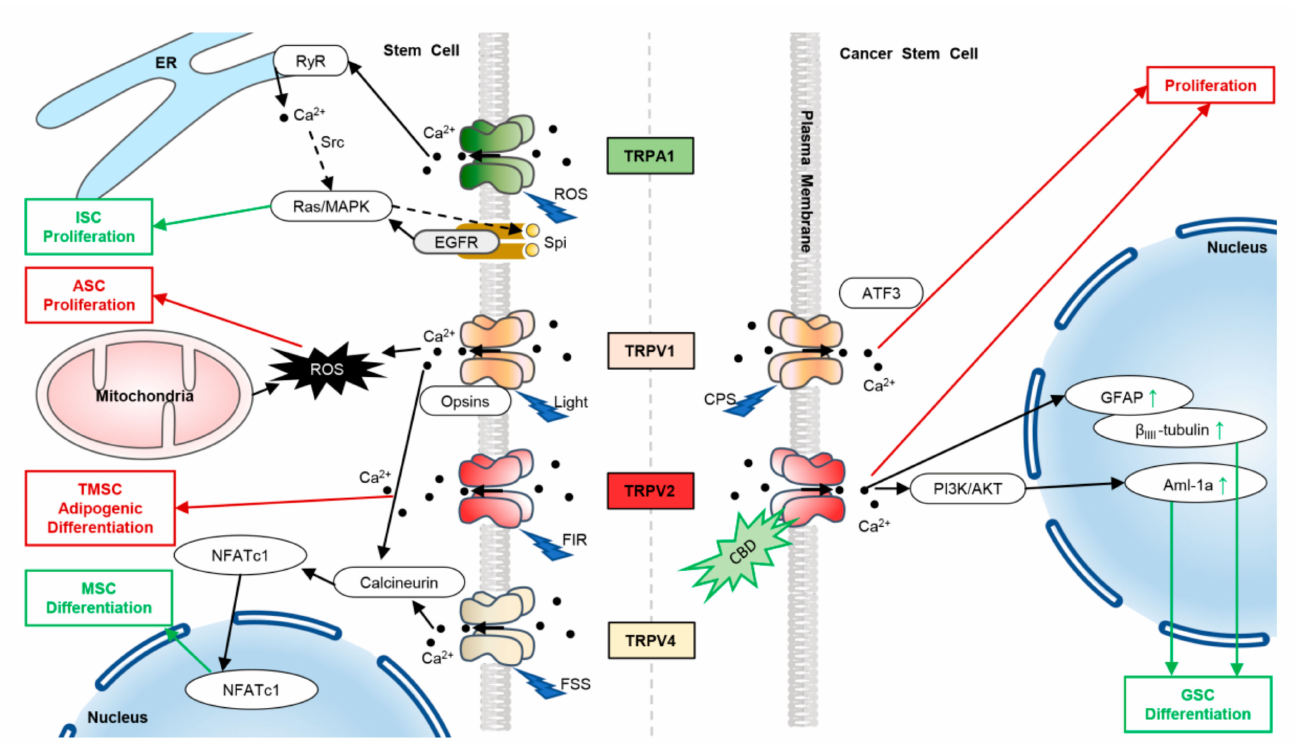
Figure 3. TRPVs and TRPA1 involved in modulating cell proliferation and differentiation in stem cells and cancer stem cells. In stem cells, activation of TRPA1 by ROS induces Ca 2+ influx, which activates the RyR channel to release Ca 2+ from ER to cytosol in ISC. The increased Ca 2+ activates Ras/MAPK signaling via Src, and further amplifies Ras/MAPK signaling by autocrine Spi-EGFR signaling. The activated EGFR-Ras/MAPK signaling then induces the proliferation of ISCs. Blue (415 nm) and green (540 nm) wavelengths of light could activate TRPV1 and increase Ca 2+ and ROS, thereby inhibiting cell proliferation in adipose-derived stem cells (ASC). Knockout of TRPV1 suppresses the expression and activities of NFATc1, leading to decreased osteoclast and osteoblast differentiation. Upon stimuli of far-infrared radiation (FIR), TRPV2 induces intracellular Ca 2+ increase and inhibits tonsil-derived MSC (TMSC) differentiation. Flow shear stress (FSS) activates TRPV4 and induces Ca 2+ influx, which mediates NFATc1 nuclear translocation, thereby promoting the osteogenic differentiation of MSCs. In cancer stem cells, TRPV1 with stimulation of capsaicin (CPS) inhibits the proliferation of NSCs and NPC-derived high-grade astrocytoma in an activating transcription factor 3 (ATF3)-dependent manner. Upon cannabidiol (CBD) application, AKT activity in GSCs has been inhibited by decreasing pAKT levels, leading to autophagy in GSCs. Meanwhile, the expressions of TRPV2 and Aml-1a, which bind to TRPV2 promoters, are both upregulated, and increased TRPV2 enriches the expression of glial fibrillary acidic protein (GFAP) and β III -tubulin, enhancing the differentiation of GSCs via the CBD-mediated autophagic process. Moreover, the activated TRPV2 inhibits GSC proliferation. Green arrows represent enhancement, red arrows represent